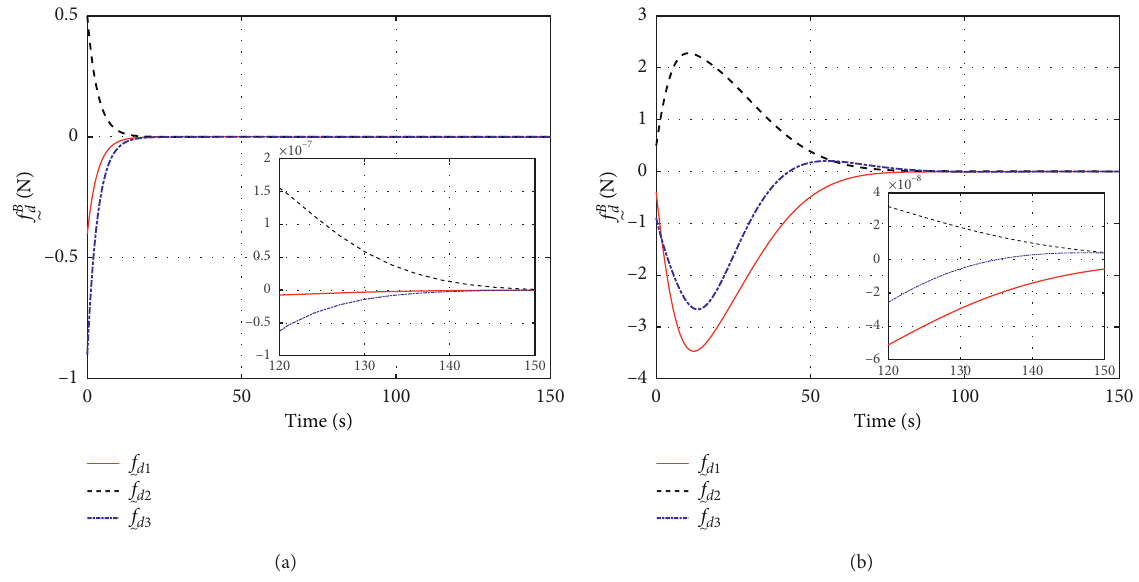
Figure 8: Disturbance force estimation errors. (a) I&I-based adaption law. (b) CE-based adaption